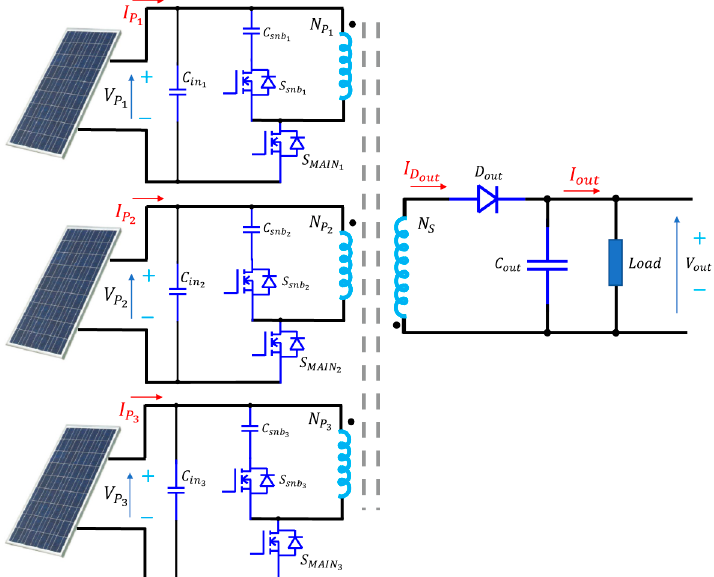
Figure 1. Topology proposed, with 𝑁 = 3 PV panels.